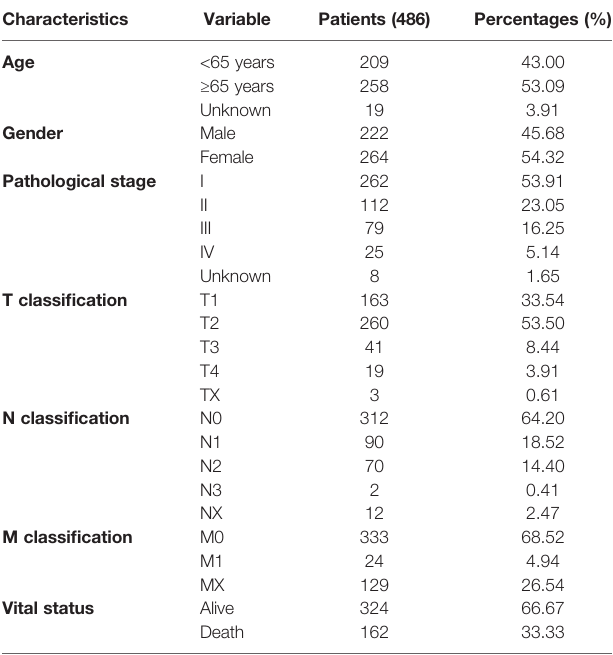
TABLE 1 | Characteristics of patients with LUAD. Characteristics